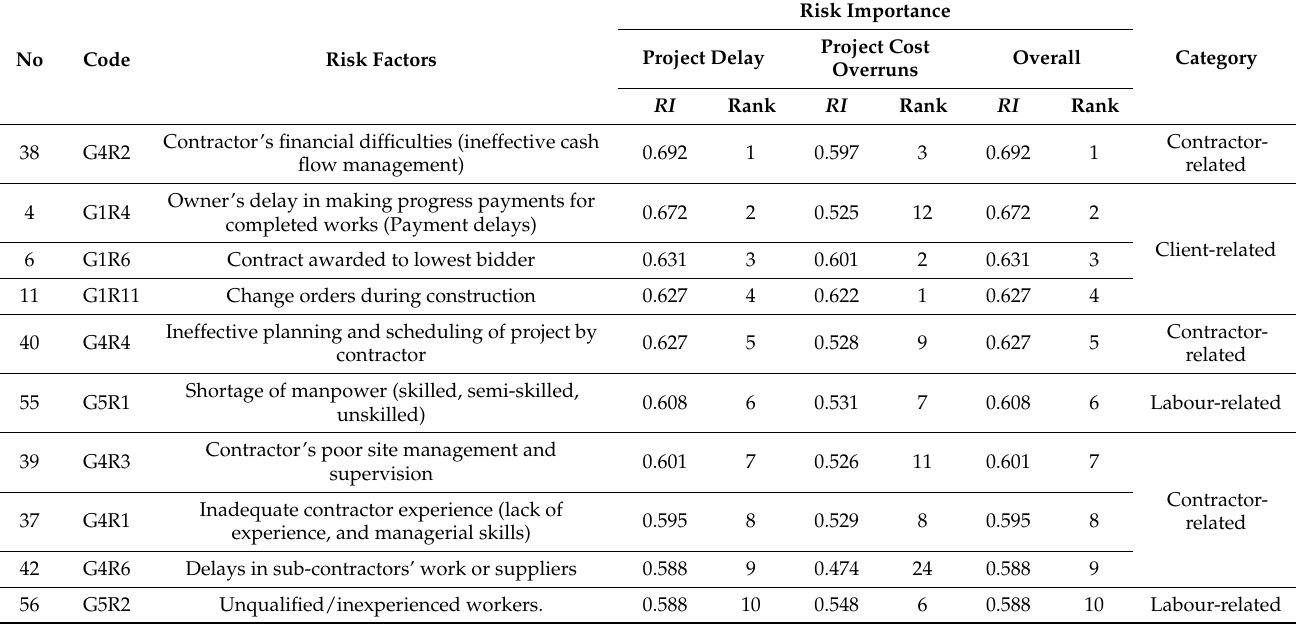
Table 3. Top 10 Risk factors that lead to delay and cost overruns in building construction